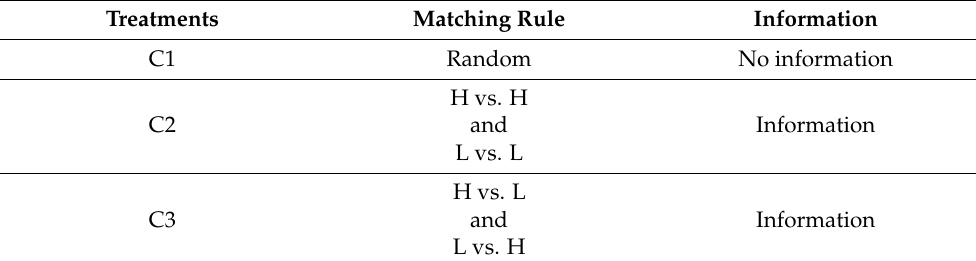
Table 1. Experimental